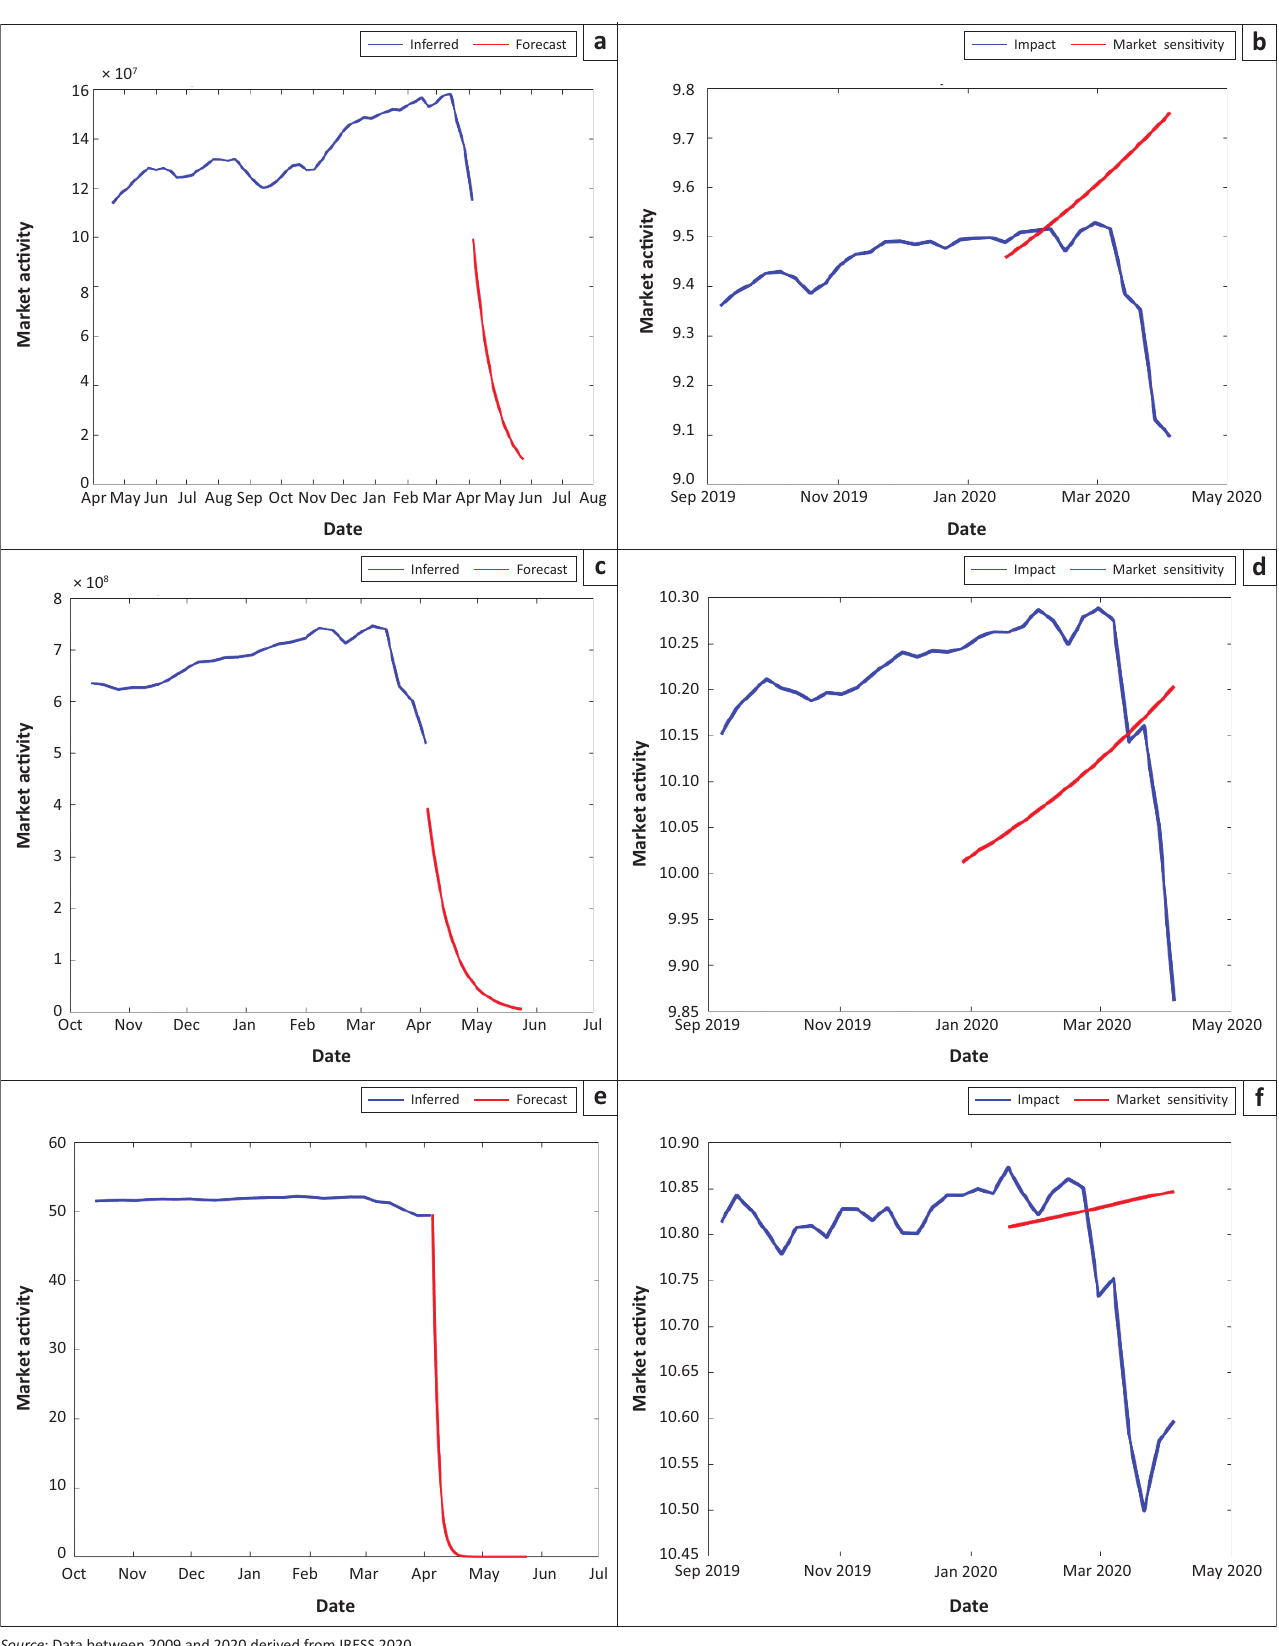
Source : Data between 2009 and 2020 derived from IRESS 2020 FTSE, Financial Times Stock Exchange; LSE, London Stock Exchange. FIGURE 2: Graphical representation of the Dax, Dow Jones Industrial Average, Financial Times Stock Exchange/Johannesburg Stock Exchange All Share, Nikkei 225 and the London Stock Exchange highlighting in column 1 the ‘Inferred’ and ‘Forecasted Impact’ using a generalised autoregressive conditional heteroscedasticity model. An autoregressive integrated moving average model is applied in column 2, highlighting the ‘Sensitivity’ and ‘Impact’ of COVID-19 on the respective stock market indices. (a) Impact of conditional variances on the Dax, (b) Dax impact covid 19, (c) Impact of conditional variances on Dow Jones, (d) Dow impact covid 19, (e) Impact of conditional variances model on FTSE, (f) FTSE impact covid 19, (g) Impact of conditional variances on the Nikkei, (h) Nikkei 225 impact covid 19, (i) Impact of conditional variances on the LSE, (j) London stock exchange impact covid 19.